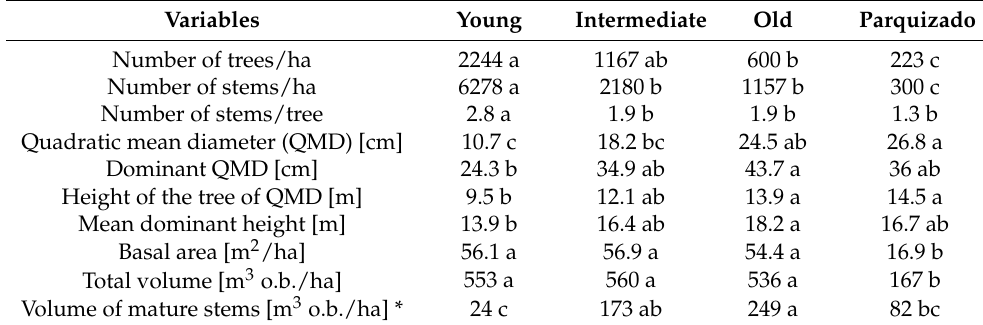
Table 3. Parameters of the different